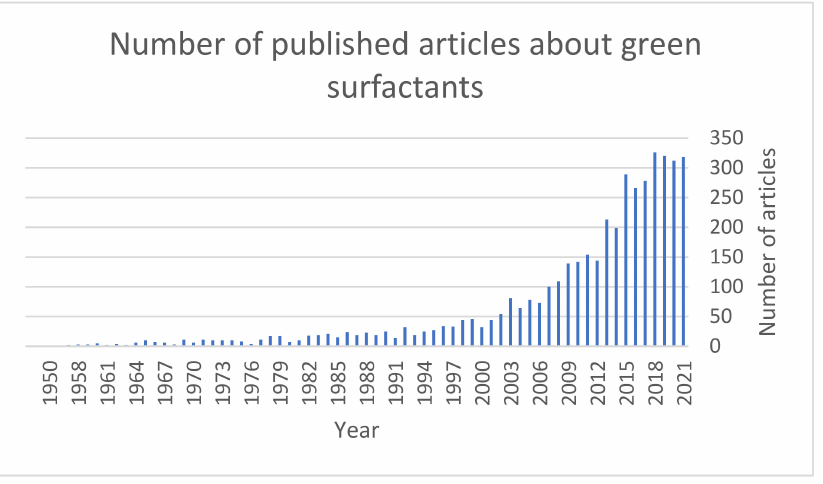
Figure 1. Graphical representation of the number of published articles about green surfactants according to the year